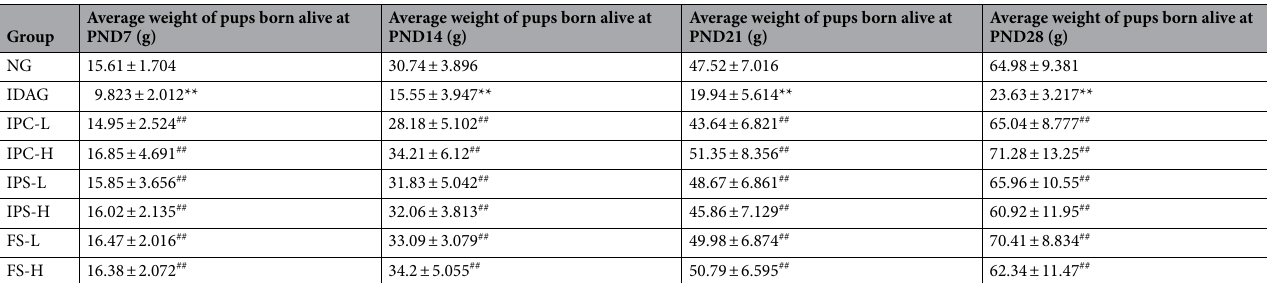
Table 2. The body weight of offspring rats. * p < 0.05, ** p < 0.01, compared with NG, # p < 0.05, ## p < 0.01, compared with IDAG. One-way ANOVA followed by Tukey multiple comparison test was used for comparison among 8 different groups.